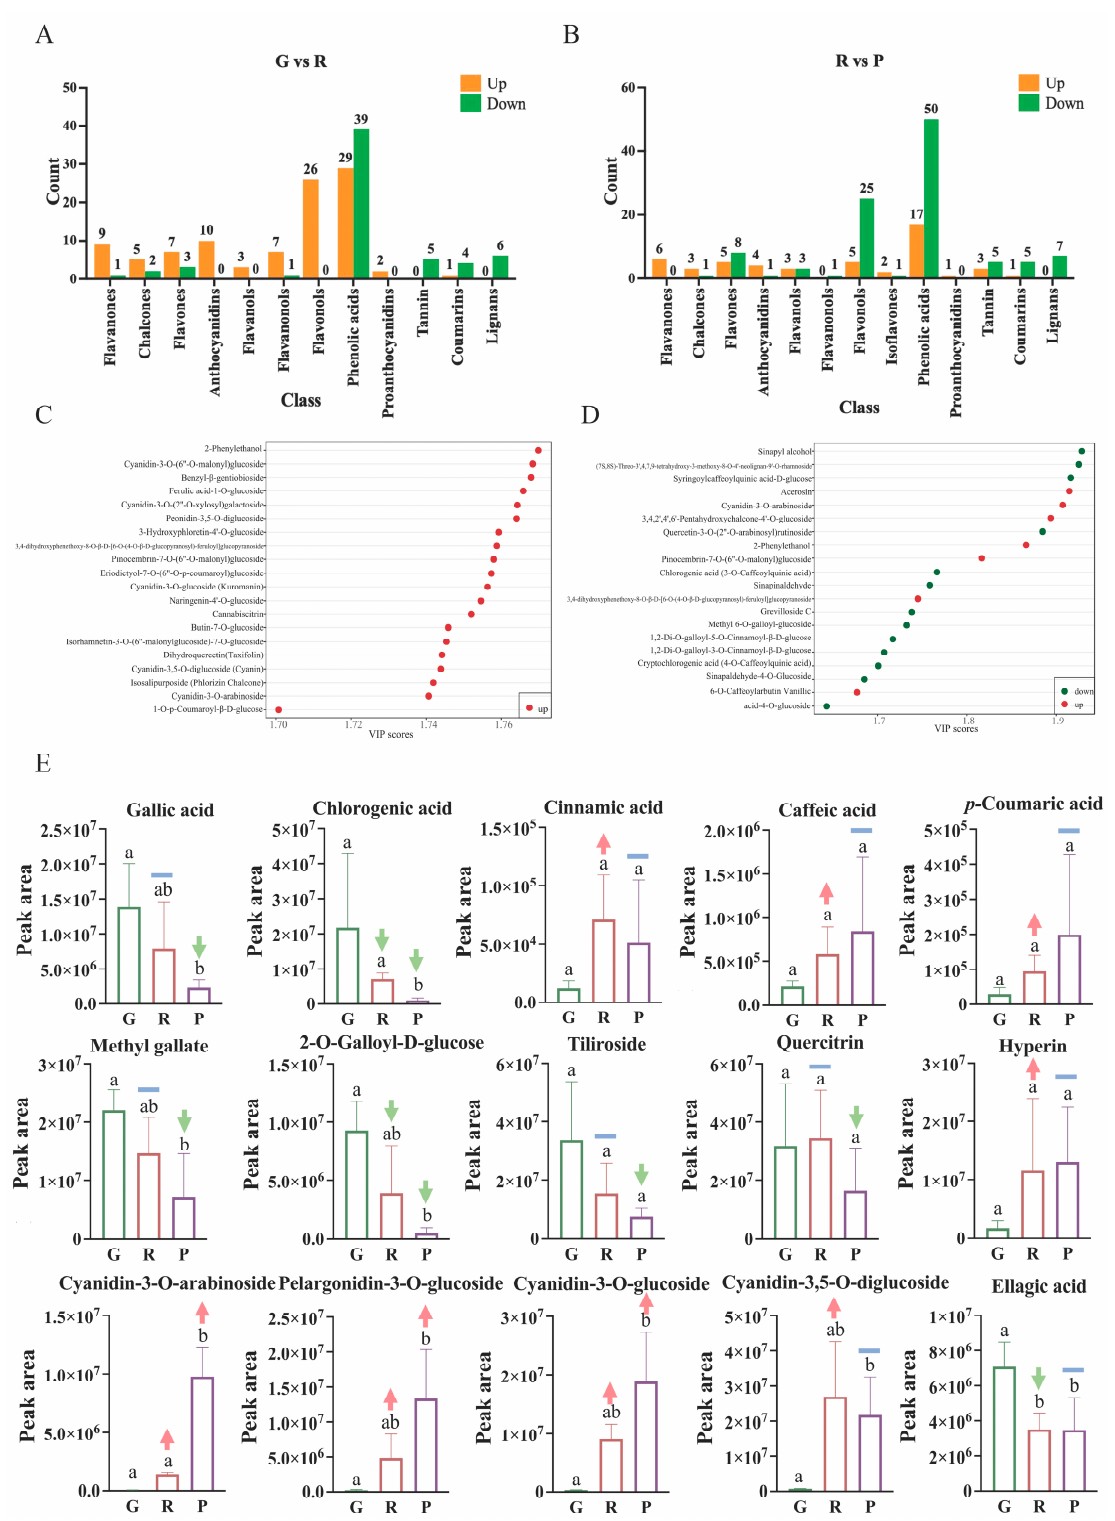
Figure 3. ( A ) The counts of differential metabolites in G vs. R. ( B ) The counts of differential metabo- lites in R vs. P. ( C ) Top 20 VIP metabolites in G vs. R. ( D ) Top 20 VIP metabolites in R vs. P. Ordinate: metabolite, Blackish green color: downregulated metabolites, Red: upregulated metabo- lites. ( E ) Changes in the major polyphenols of fruit at different developmental stages (Different lowercase letters indicate significant differences ( p value < 0.05); the red arrow indicates that